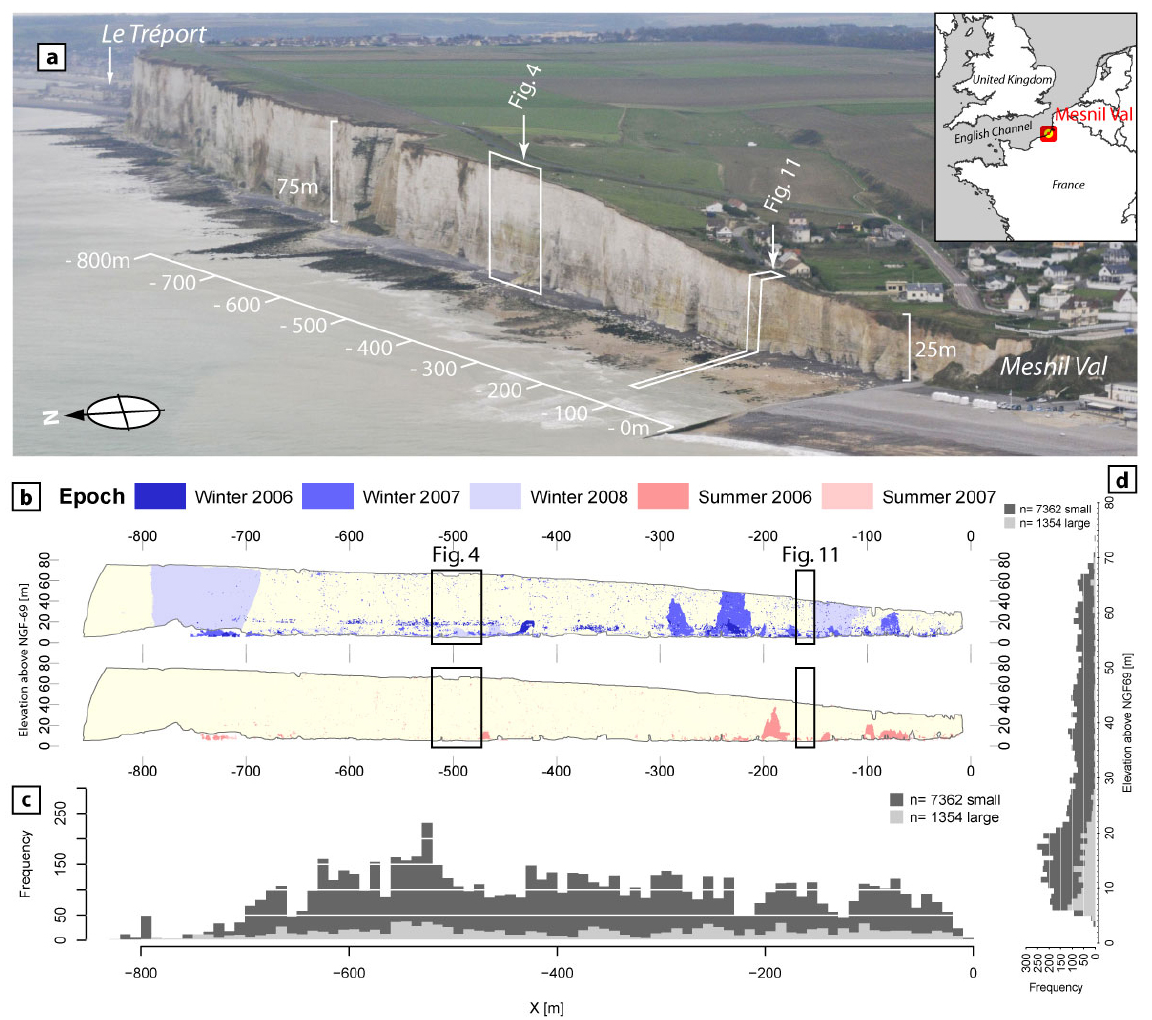
Figure 1. (a) Aerial view of the Mesnil-Val coastal rock cliff site (NW France, location indicated in the inner panel), photo T. Dewez, 5 October 2010; (b) distribution of erosion scars over the cliff surface considering the measurement epochs in winter (top) and in summer (bottom); frequency of small and large scars alongshore (c) and along the cliff height (d) . The histograms are constructed by considering the centroids of the scars (see also Fig. 2). Location of Figs. 4 and 11 are